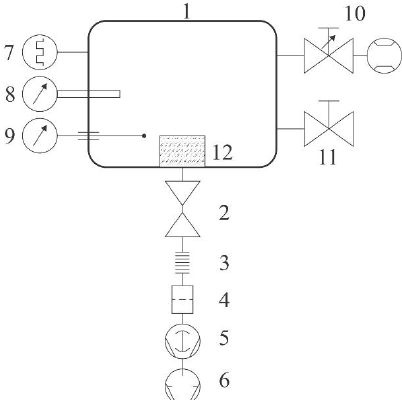
Figure 1. The schematic diagram of the vacuum of the small plasma reactor. 1—discharge chamber, 2—narrow tube with butterfly valve, 3—two-meter long bellows with diameter of 40 mm, 4—trap for fine powder, 5—Roots pump, 6—two-stage oil rotary pump, 7—Pirani vacuum gauge, 8—optical fiber with lens and spectrometer, 9—catalytic probe, 10—gas feeding flow measurement system, 11—air inlet valve, and 12—sample